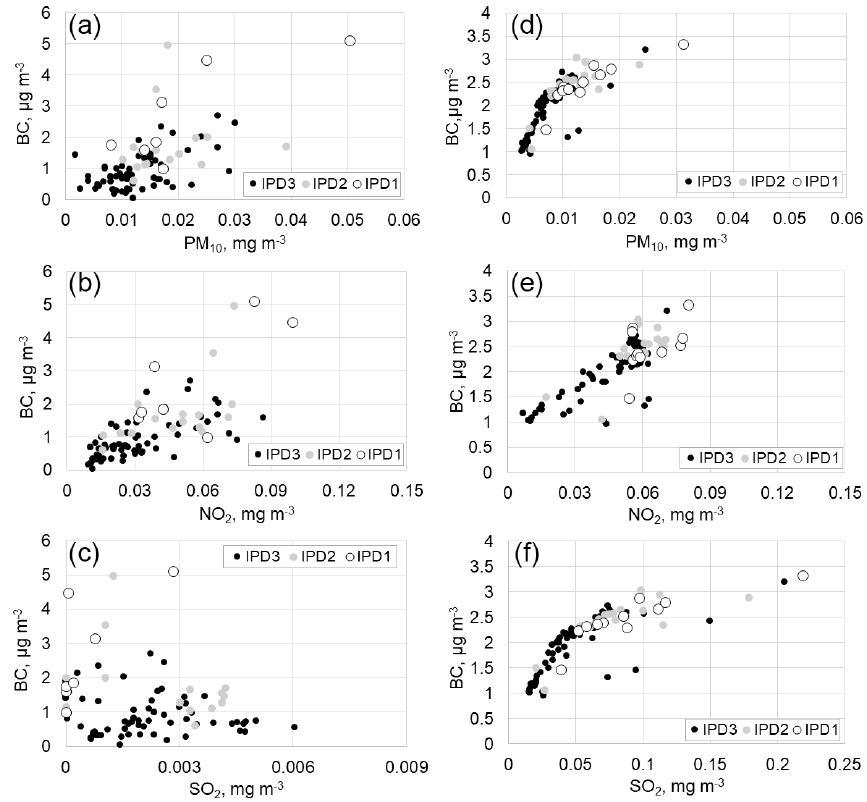
Figure 6. The dependence of measured (left column) and model (right column) BC mass concentrations as a function of PM 10 (a, d) and aerosol gas precursors (NO 2 – b, e ; SO 2 – c, f ) for different IPD regimes for April–May 2018. The cases affected by biomass burning aerosol were excluded.